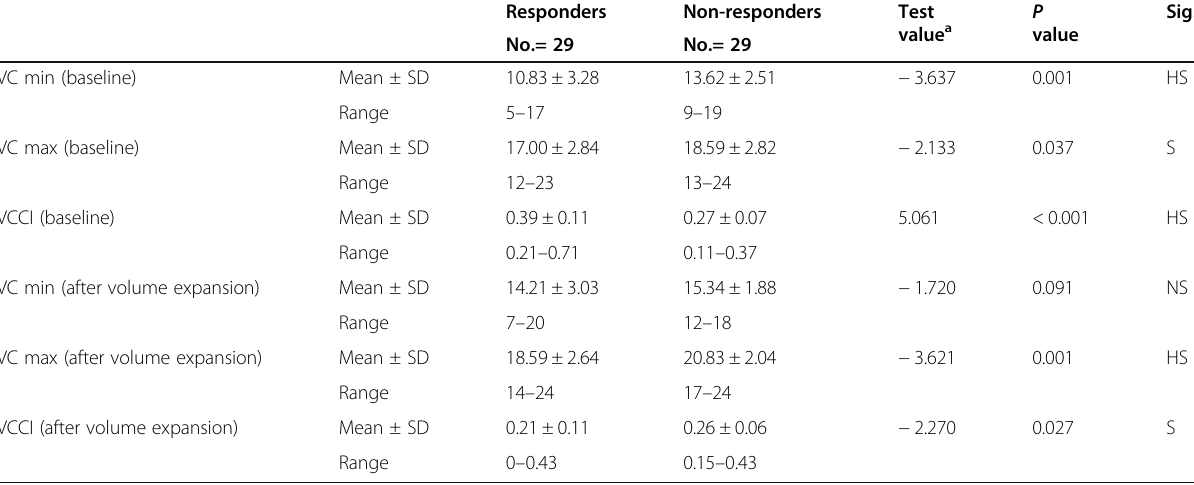
Table 4 Comparison between responders and non-responders regarding inferior vena cava parameters (in mm) and collapsibility index of the studied